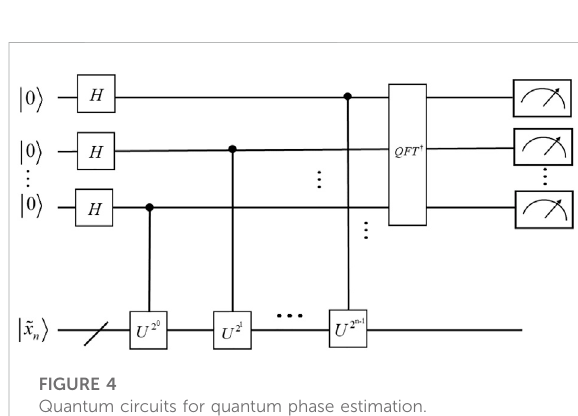
FIGURE 4 Quantum circuits for quantum phase estimation.